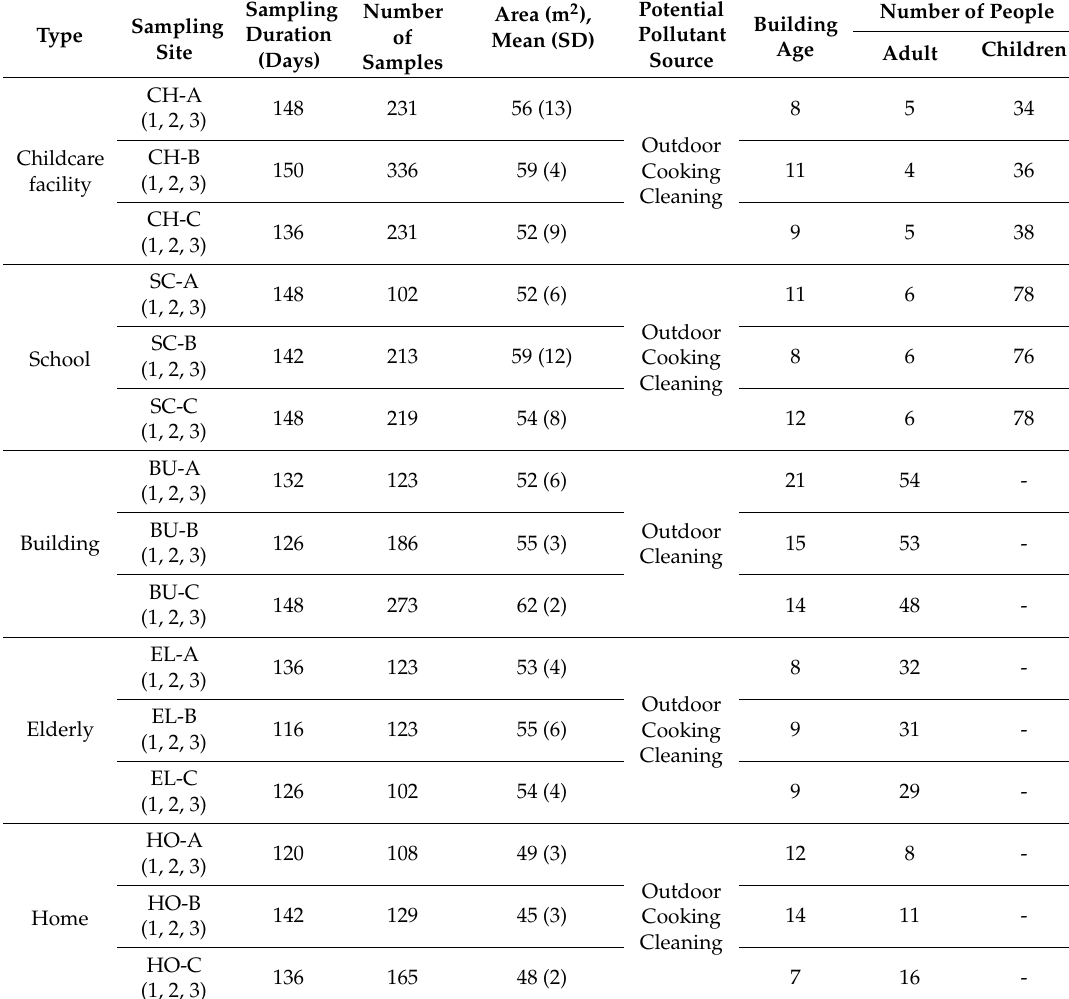
Table 1. Characteristics of sampling sites in all investigated